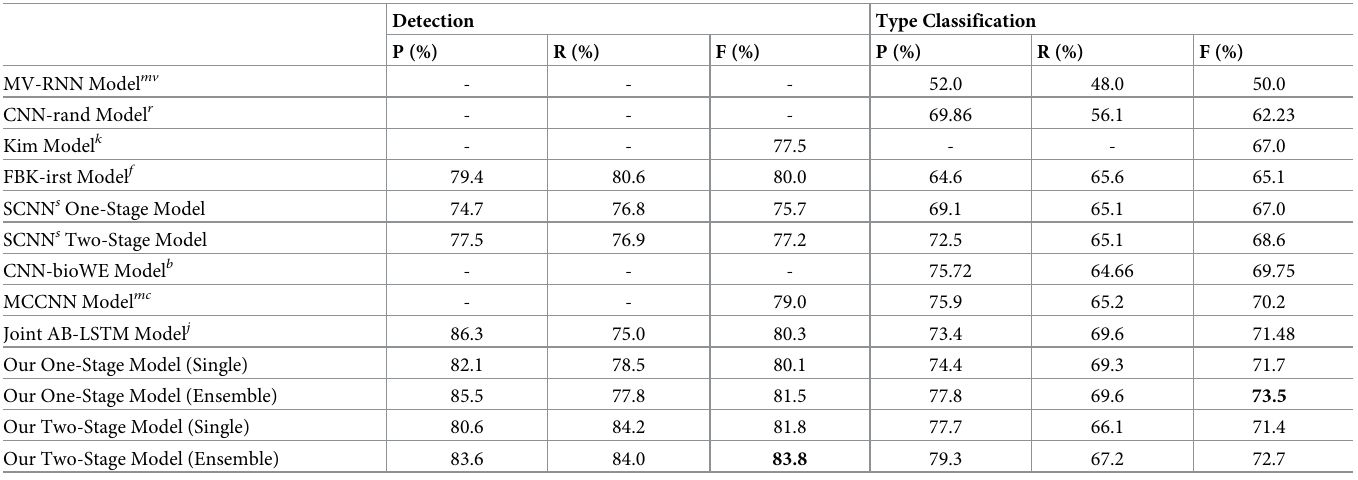
Table 5. Comparison between our proposed model and existing